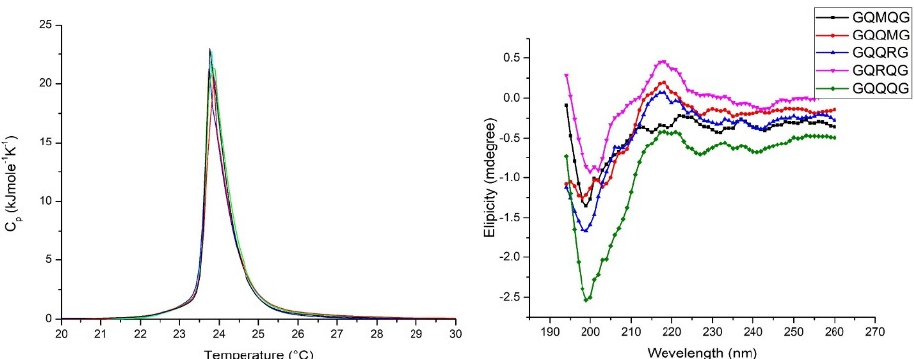
Figure 4. Left panel: DSC scan of DMPC SUV in the presence of penta-peptides. For the sake of clarity, the Cp profiles of GQRQG and GQMQG were not reported because of the overlap with the DMPC curve. Right panel: CD spectra of DMPC SUVs suspension in the presence of penta-peptides. SUV concentration, 1 mL/mL; penta-peptide concentration 40 µM; pH = 7.04 PBS buffer; ion strength 0.1.